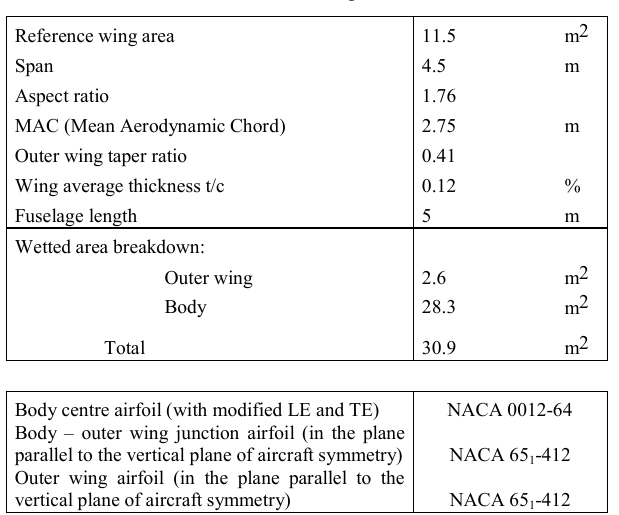
Table 2. PW-124 main geometric data